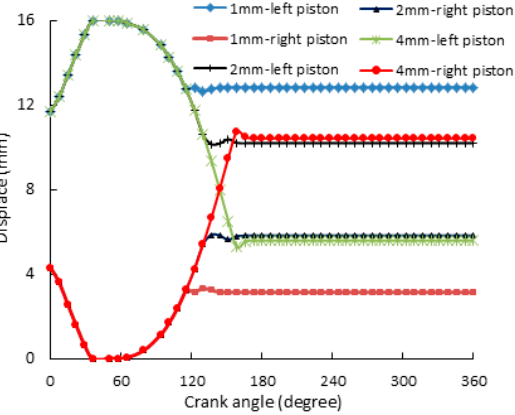
Figure 9. Displacement of the cylinder piston at 800 r / min with di ff erent adjustment quantities.